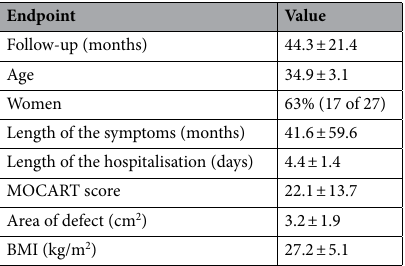
Table 1. Demographic data of the patients before the revision surgery.